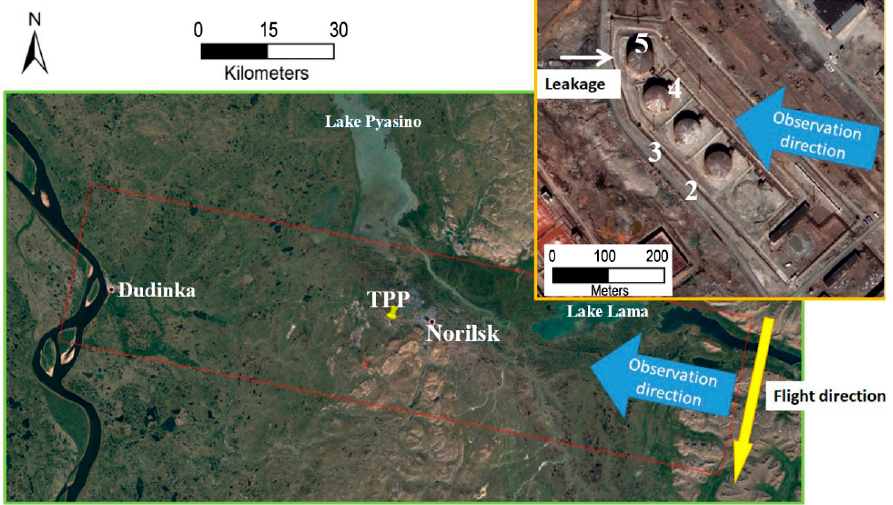
Figure 1. Google Earth image of TPP area. White numbers 2–5 on the inset enumerate fuel tanks.